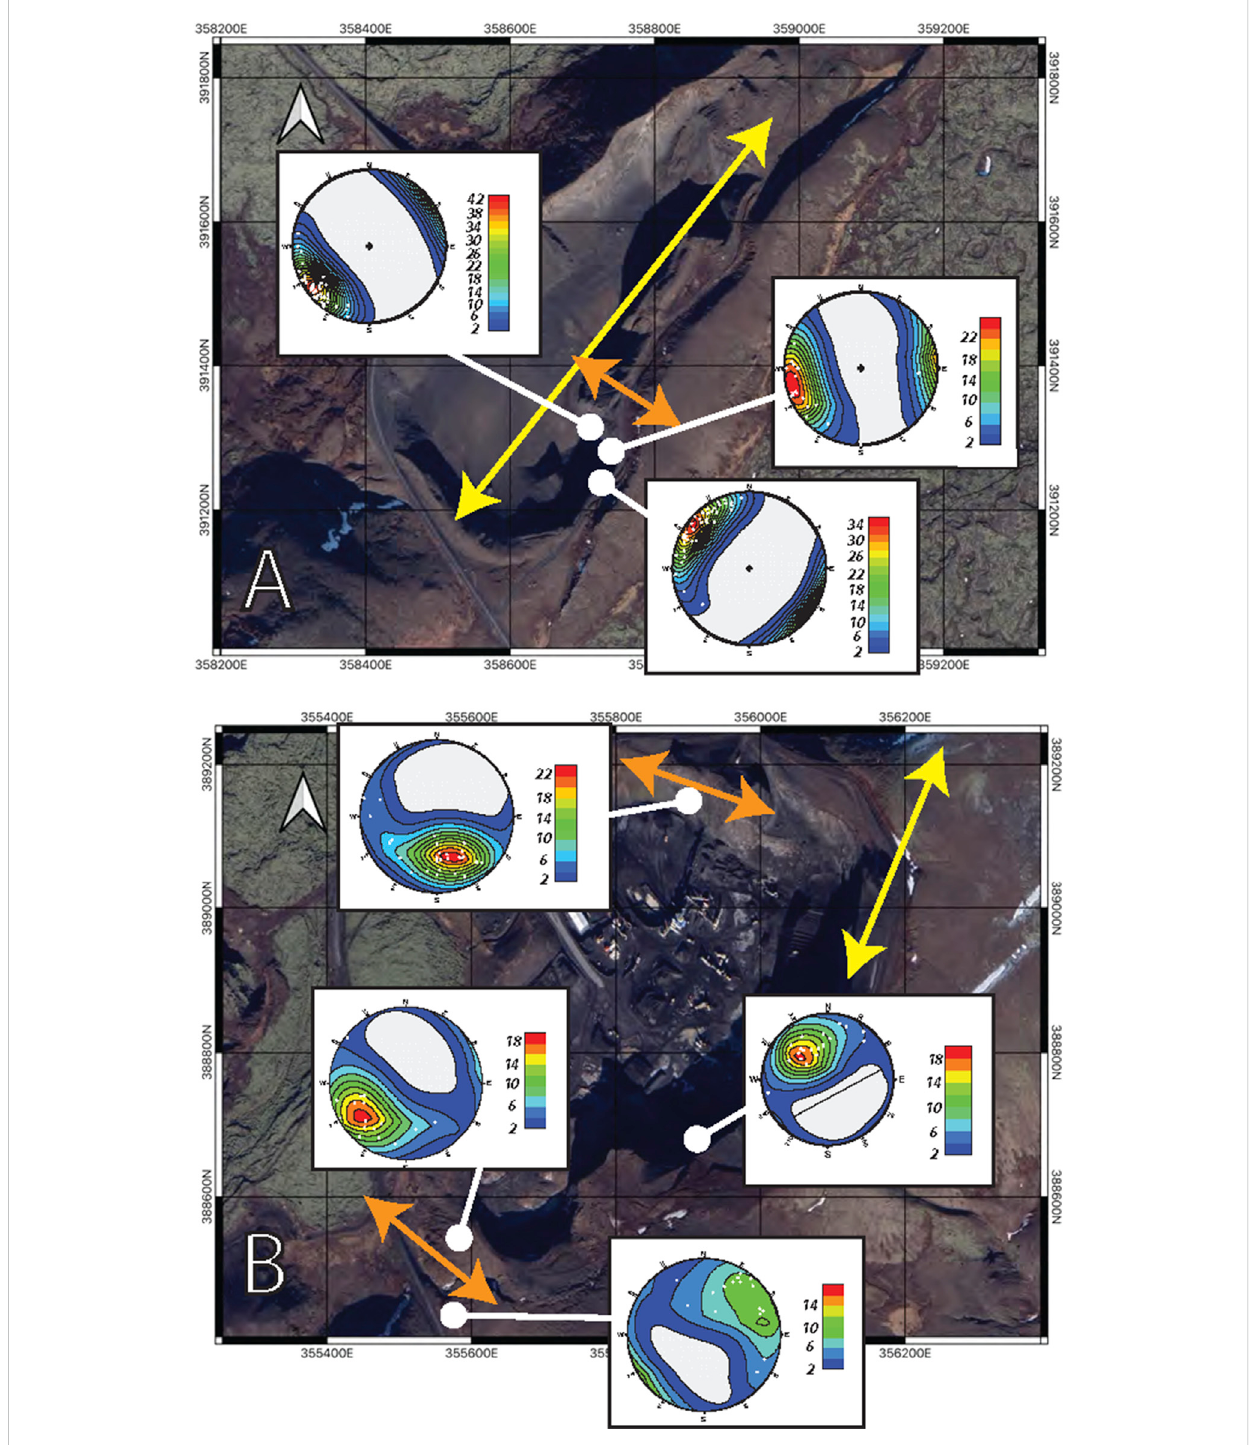
FIGURE 6 Quanti fi cation of pillow orientations. (A) Satellite image of the Central Wall of Undirhliðar showing populations of pillow plunges. (B) Satellite image ofthecentralandsouthernwallsatVatnsskarðquarryshowingpopulationsofpillowplunges.In (A,B) yellowarrowsshowthegeneraltrendoftheoverall ridge, and orange arrows show fi ssure trends inferred from pillow plunge